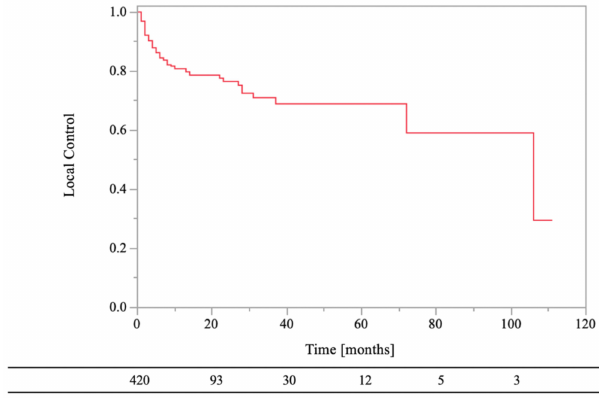
Figure 3. Local control of bone metastases.